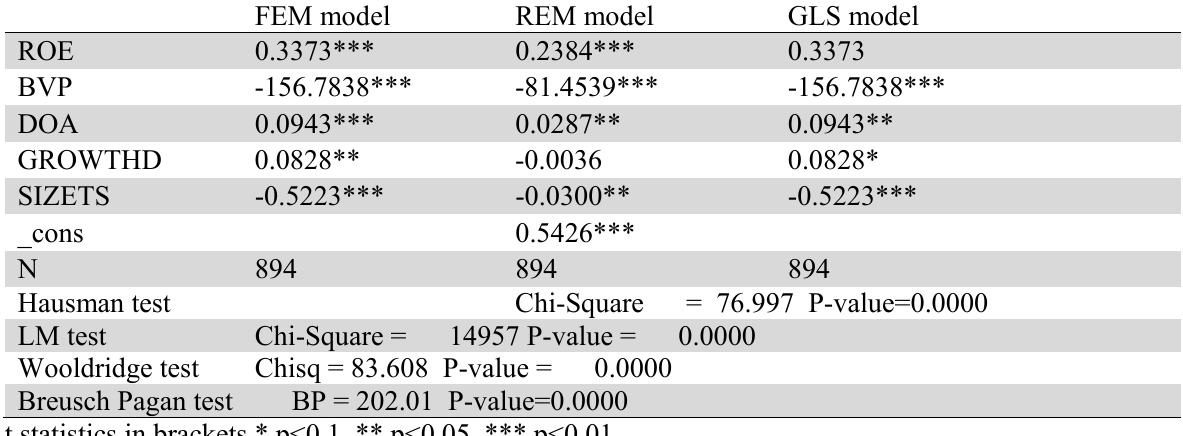
Regression with the profitability variable of